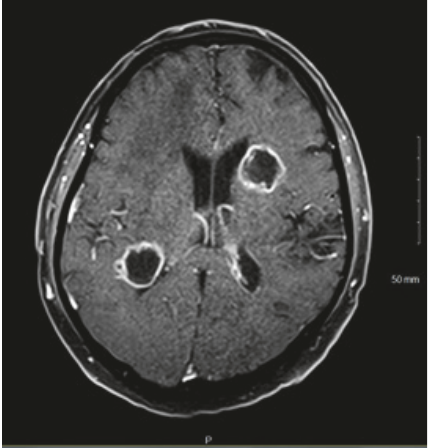
Figure 1: Axial contrast enhanced T1 WI brain MRI demonstrating rim enhancing lesions in the right peritrigonal white matter and left corona radiata.